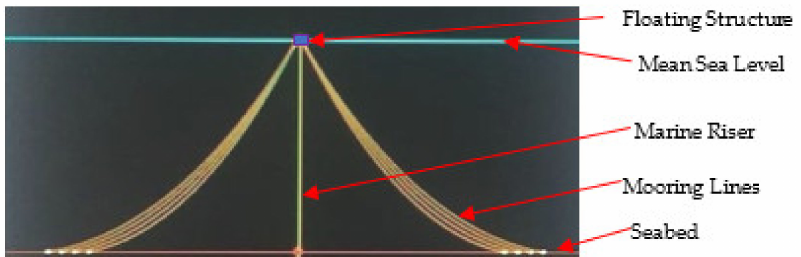
Figure 5. A labelled 3D hydrodynamic model of a semisubmersible platform showing the moorings and marine riser, designed in OrcaFlex